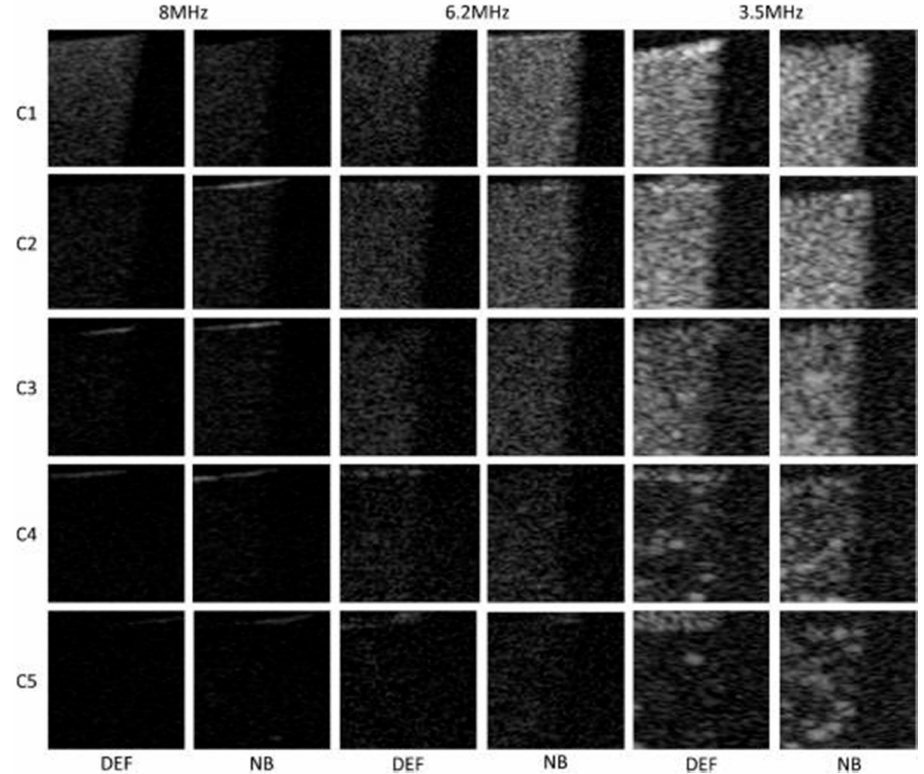
Figure 9. Contrast harmonic images of NB and commercially available Definity ® MB (DEF) at di ff erent concentrations and frequencies. Reproduced with permission from [161]. Copyright Elsevier,